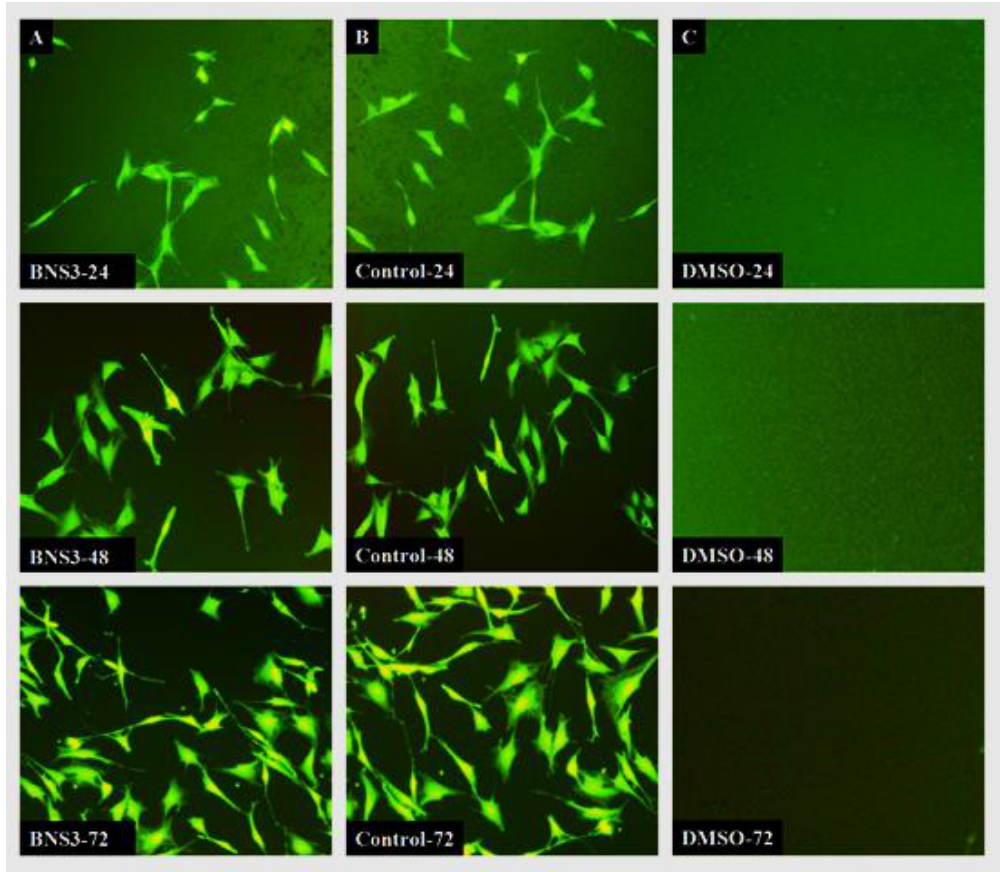
Figure 9. Morphological changes in cells observed through attached cells on the coated surface. Untreated but tissue culture treated wells without any additional coating material used as positive control wells. 1% DMSO as a negative control. ( A ) Sample BNS 3; ( B ) positive control; ( C ) negative control at 24, 48 and 72h.